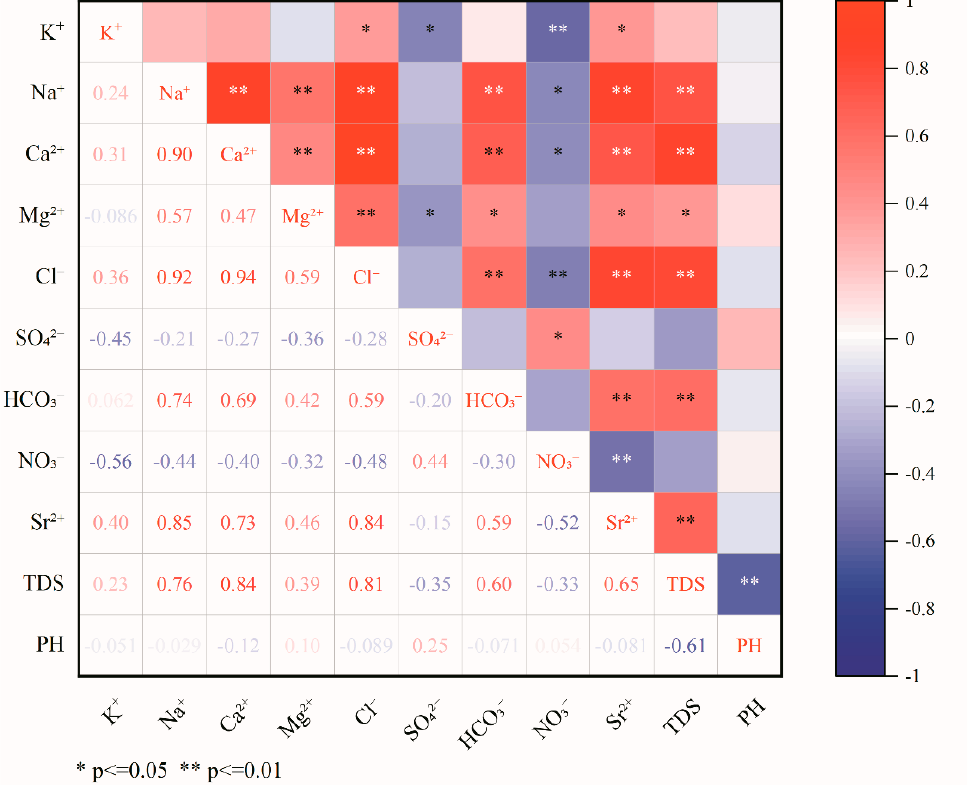
Figure 4. Correlation coefficients between hydrochemical parameters of Sr-rich groundwater.